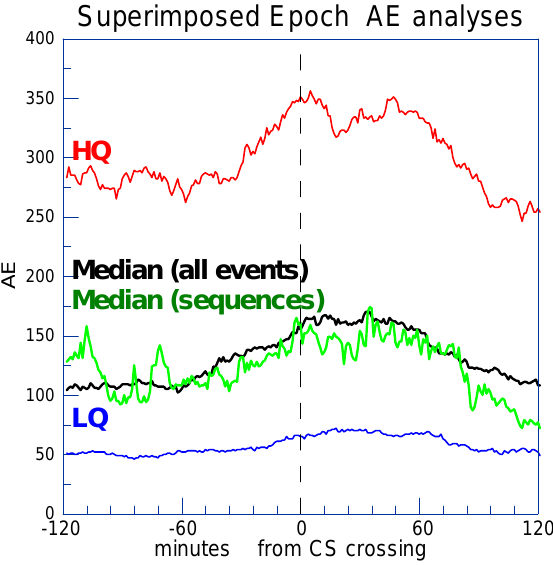
Fig. 10. Superposed epoch analysis of AE-index data with respect to the time of observation of fast CS crossing.